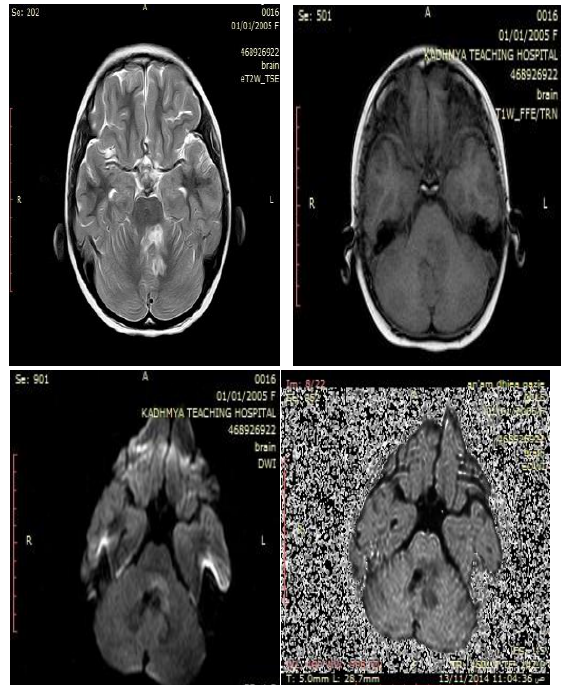
Figure (3)A-Axial T2 W show midline posterior fossa SOL of 10 year female . B-Axial T1 post Gd the SOL heterogeneous pattern of enhancement .C-axial DWI shows an intermediate signal intensity of the lesion restricted diffusion-D the tumor was confirmed histopathology as ependymoma